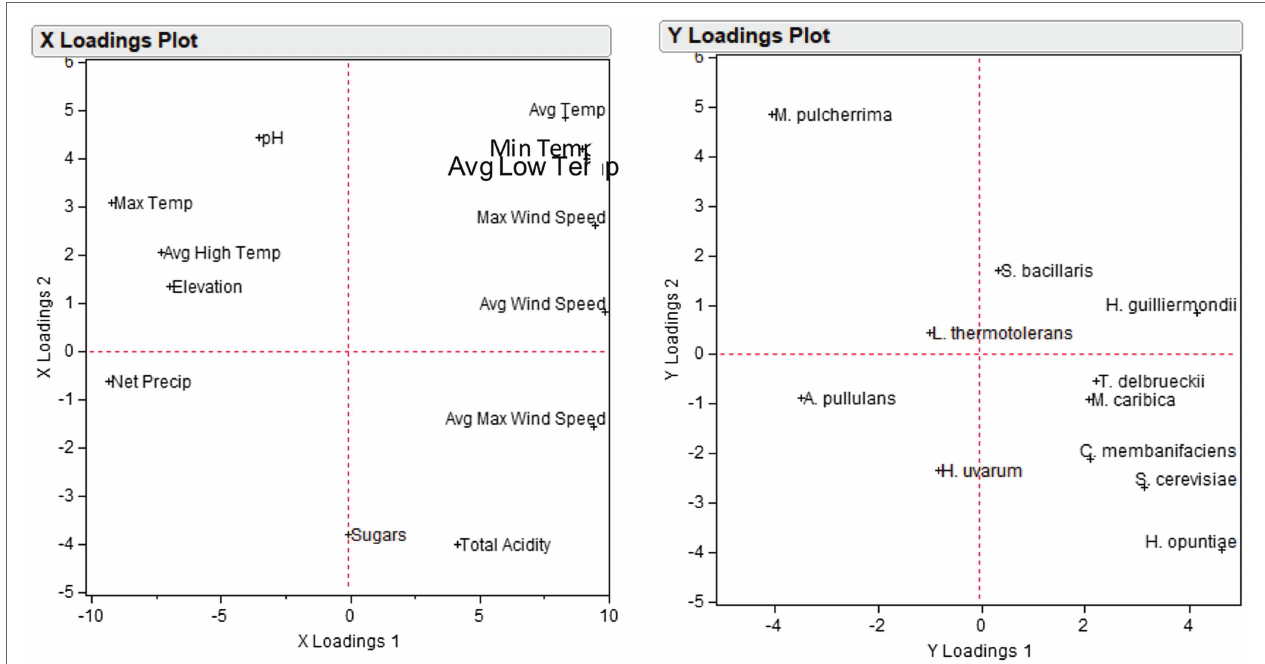
FIGURE 7 | Loading plots of partial least squares regression analysis PLSR of 13 environmental variables (X loadings plot) and 11 yeast populations (Y loadings